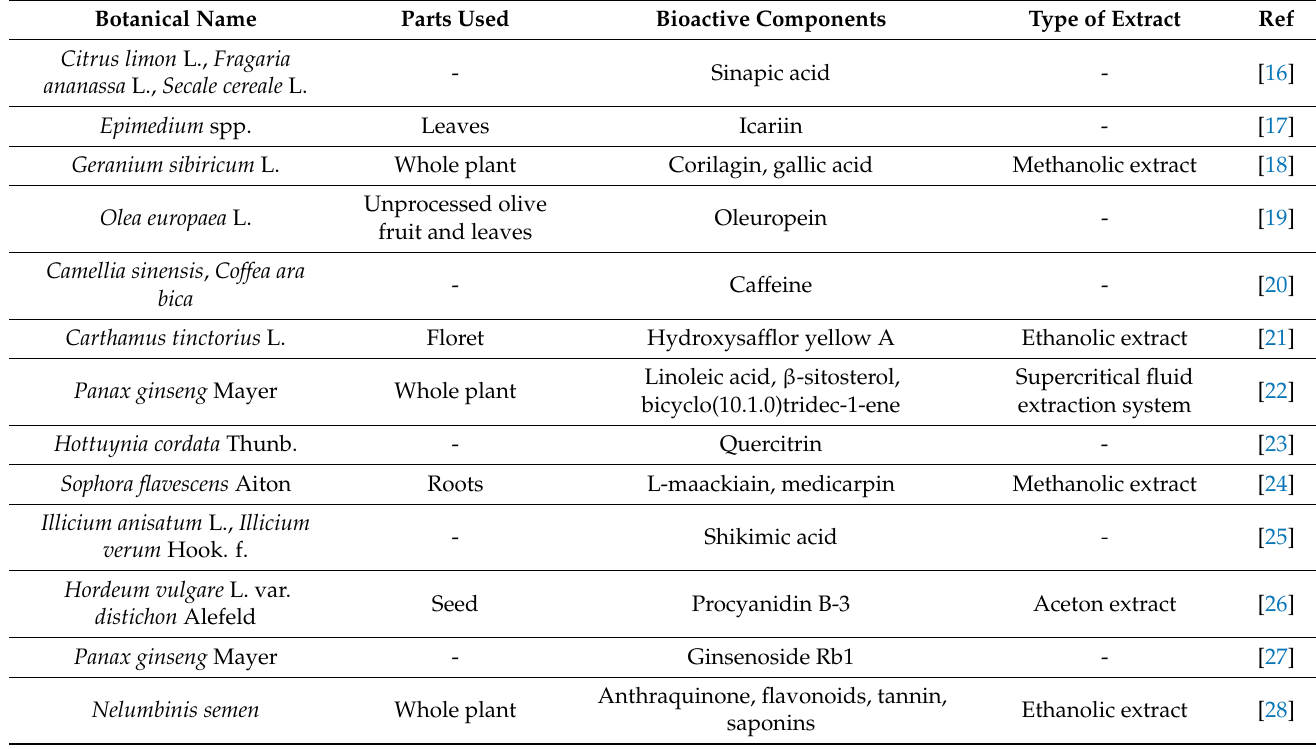
Table 1. Bioactive components from plants with hair-growth-promoting therapeutic